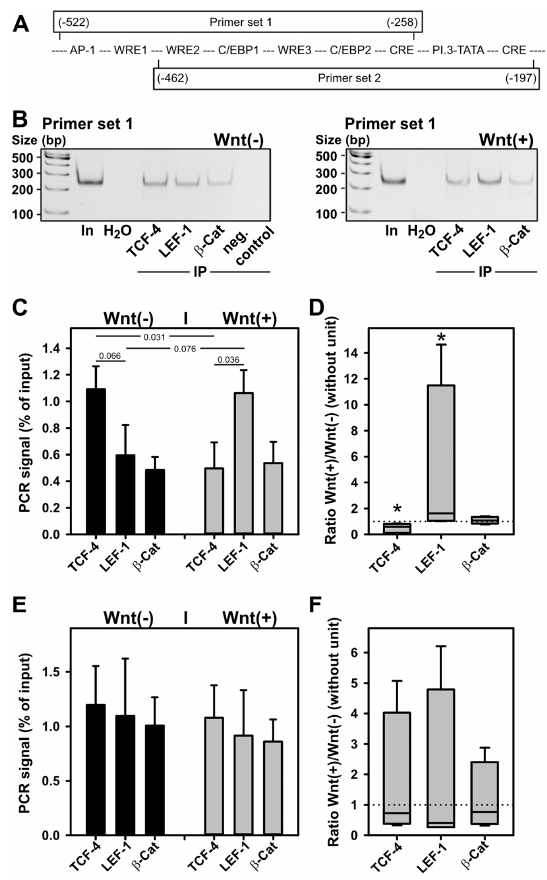
Figure 5. LEF-1 replaces TCF-4 on WRE1 of the aromatase promoter in BAFs upon WNT3a treatment. BAFs were incubated for 24 h in serum-free medium with 10 µM forskolin ±50% WNT3a CM (indicated as Wnt( − ) and Wnt(+), respectively). ChIP was performed as described in Methods. An- tibodies used for immunoprecipitation were anti-TCF-4 (H-125) (TCF-4), anti-LEF-1 292 (LEF-1), or anti- β -catenin (clone 14) ( β -Cat). ( A ) Two primer sets were used for subsequent PCR: primer set 1 defines an amplicon, which includes all WREs in the aromatase promoter I.3/II region, whereas pri- mer set 2 amplifies a region containing only WRE2 and WRE3. Boxes representing amplicons: num- bers in parentheses indicate position in relation to the promoter II transcriptional start site; middle line indicates positions of identified and putative cis-elements in the promoter region (for details see Figure 3). ( B ) Representative polyacrylamide gels from one PCR with primer set 1. In: 1:50 di- luted DNA input; H 2 O: water used as PCR control without template; neg. control: Protein G Se- pharose alone used for immunoprecipitation (IP). For quantitation, band intensities obtained from ChIP reactions were expressed as %-values of input signal: ( C ) Means ± SEM obtained with BAFs